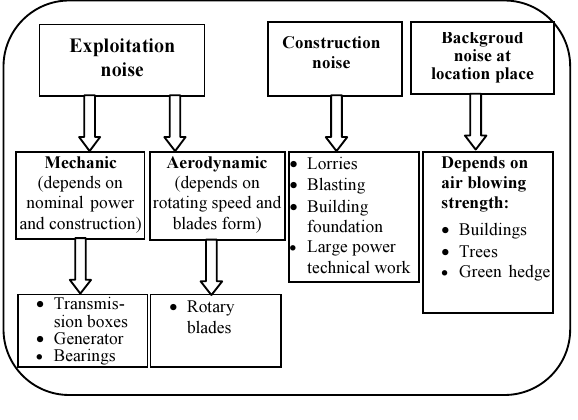
Fig. 1. Sources of the wind power plant‘s